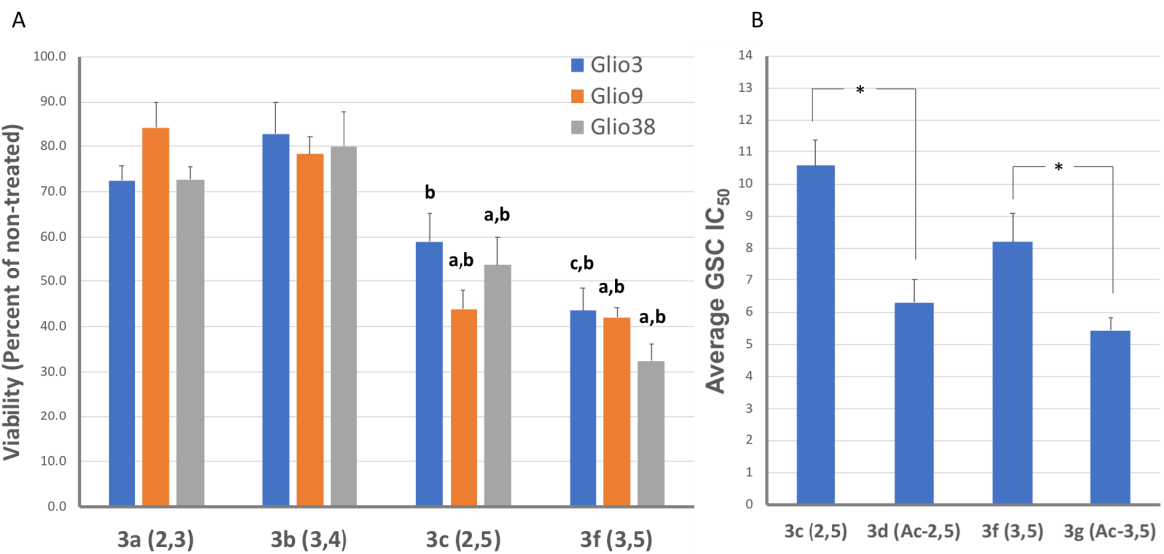
Figure 3. Effect of methoxy position and amino modification of chalcone on GSC cytotoxicity. ( A ) GSC lines Glio3, Glio9 and Glio38 were treated with 10 µM of chalcones 3a , 3b , 3c and 3d and viability determined 72 h later. a p < 0.01 compared to chalcone 3a , b p < 0.01 compared to chalcone 3b , c p < 0.05 compared to chalcone 3a . ( B ) Average IC 50 of each chalcone across the 3 GSC lines. * p < 0.05.